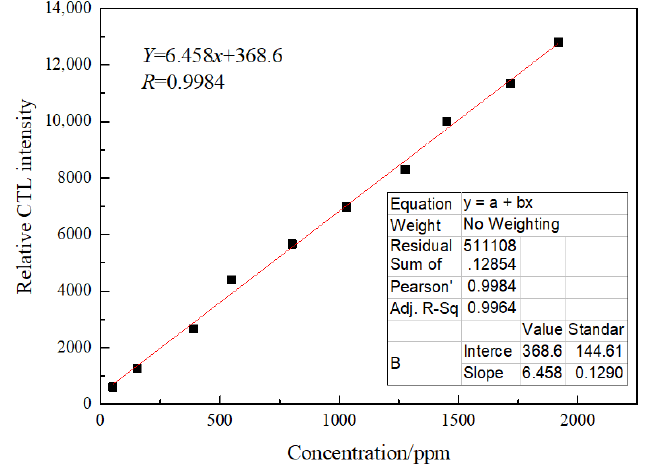
Figure 9. The calibration curve for acetone (temperature: 210 °C, flow rate: 310 mL/min, wavelength: 590 nm).